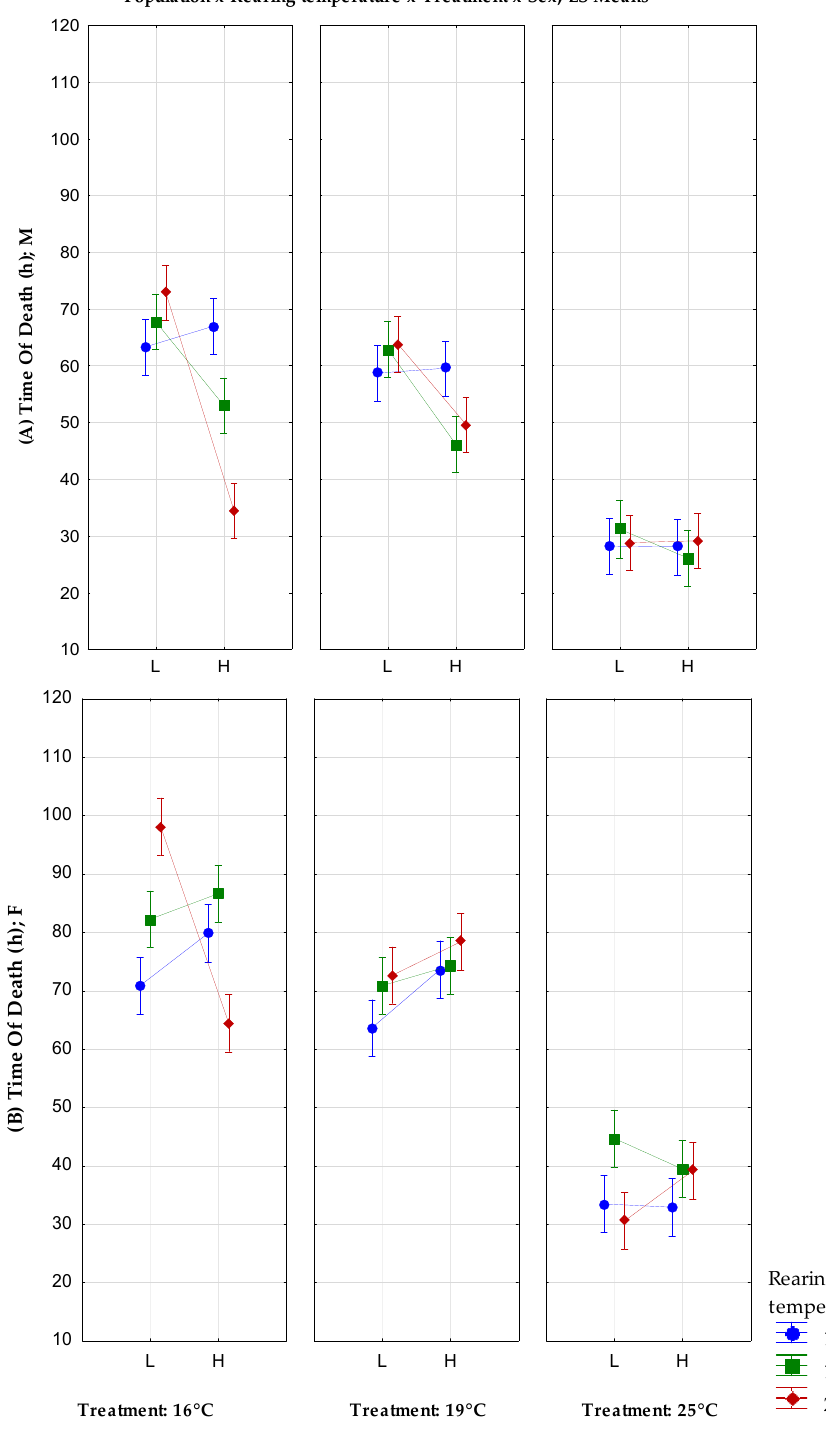
Figure 1. Full factorial GLM analysis of desiccation resistance with a fixed factors population, rearing temperature, treatment temperature, and sex; ( A ) males; and ( B ) females. Vertical bars denote a 0.95 confidence interval. M—males; F—females; L—population originating from lower altitude; H—population originating from the higher altitude. The modified figure was previously published in the Proceedings of the 1st International Electronic Conference on Entomology, 1–15 July 2021, doi:10.3390/IECE-10532.